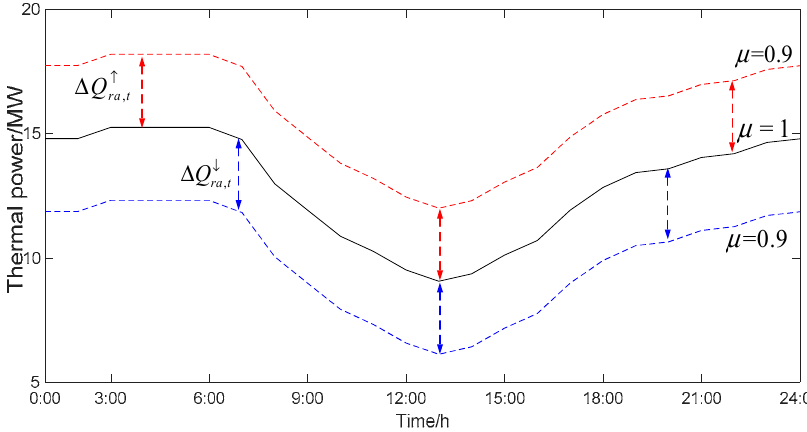
Figure 8. Thermal demand envelope based on user thermal comfort.